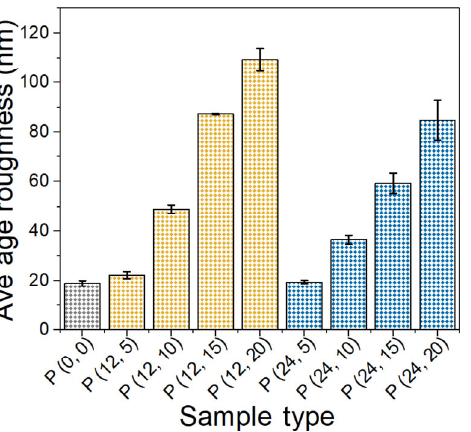
Fig. 6 Average surface roughness of PDA/PTFE coatings on smooth and laser textured stainless steel.